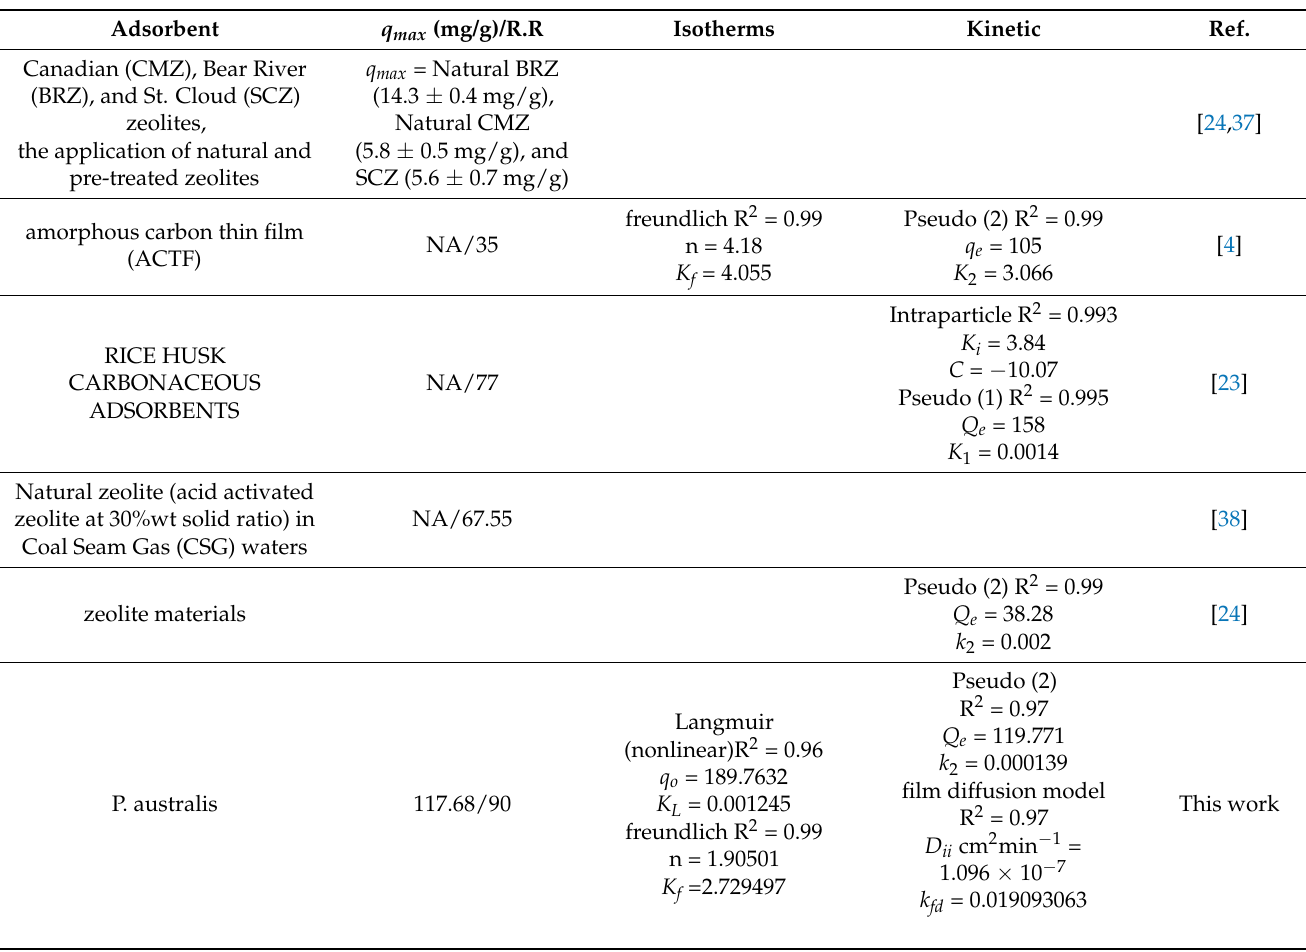
Table 9. Na + values for maximum adsorption of P. australis in comparison with other adsorbents in the literature published. Adsorbent q max (mg/g)/R.R Isotherms Kinetic Ref. Canadian (CMZ), Bear